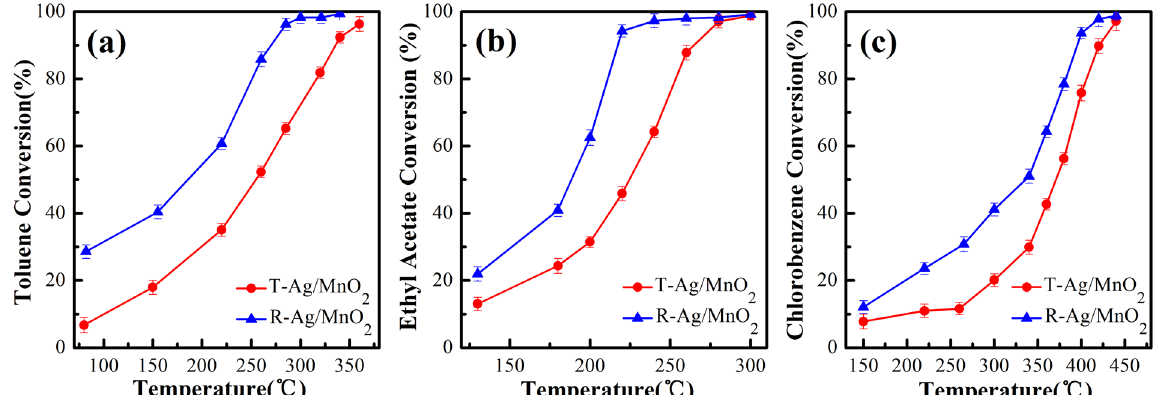
Figure 2. Catalytic activity of Ag/MnO 2 -cordierite catalyst for ( a ) toluene, ( b ) ethyl acetate, ( c ) chlorobenzene at different temperatures; reaction conditions: VOCs = 1000 ppm; catalyst content = 0.1 g/cm 3 ; SV (space velocity) = 10,000 h − 1